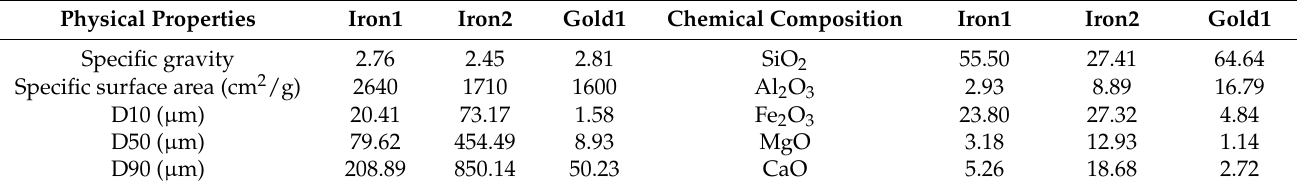
Figure 2. Particle size distribution of the tailings used in this study. Table 1. Main physical and chemical properties of the